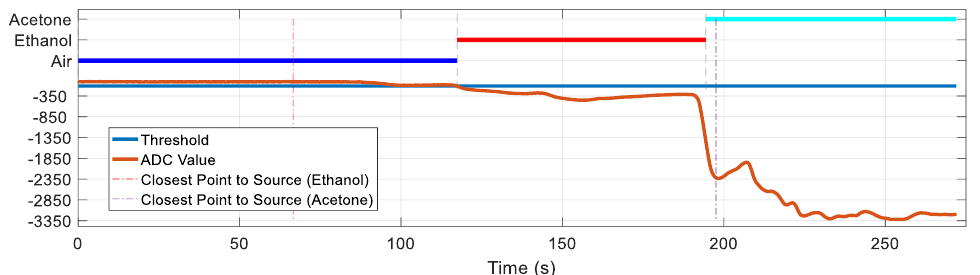
Figure 10. Results of exploration with two gas sources (ethanol and acetone) and HVAC turned off (Scenario III). Top: map of the arena (built by the robot) and mean sensor array response overlaid on the robot trajectory using two colors based on the classifier output (red for ethanol and cyan for acetone); bottom: output of the PLS-DA classifier and mean sensor array response (for visual clarity, we added a threshold that indicates the mean array response during the commutation from air to ethanol).